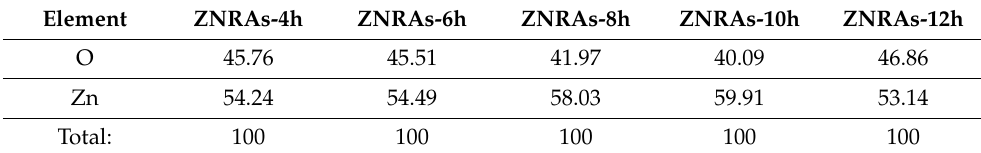
Table 1. Atomic% of Zn and O in the ZNRAs obtained from EDX spectral analyses. Element